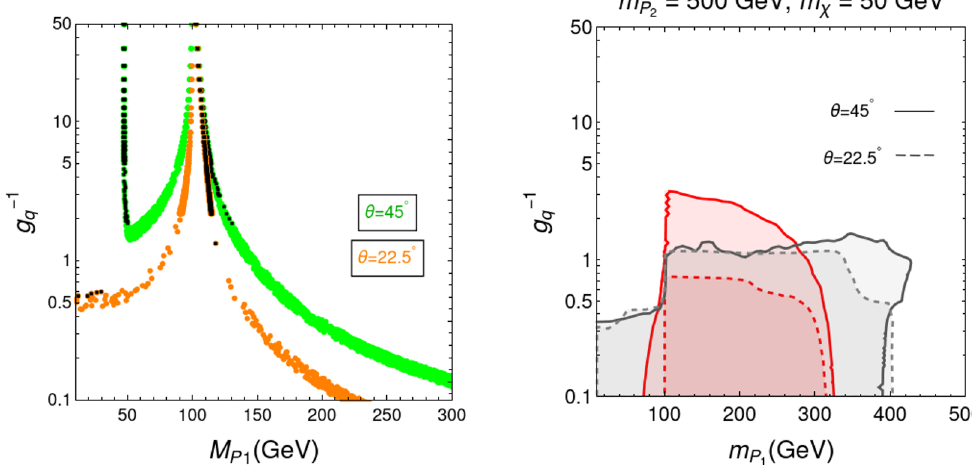
Figure 6 . Cosmology (left) and LHC (right) constraints on the model for two representative values of θ , taken to be π/ 8 and π/ 4 . We make use of the same colour code as in figure